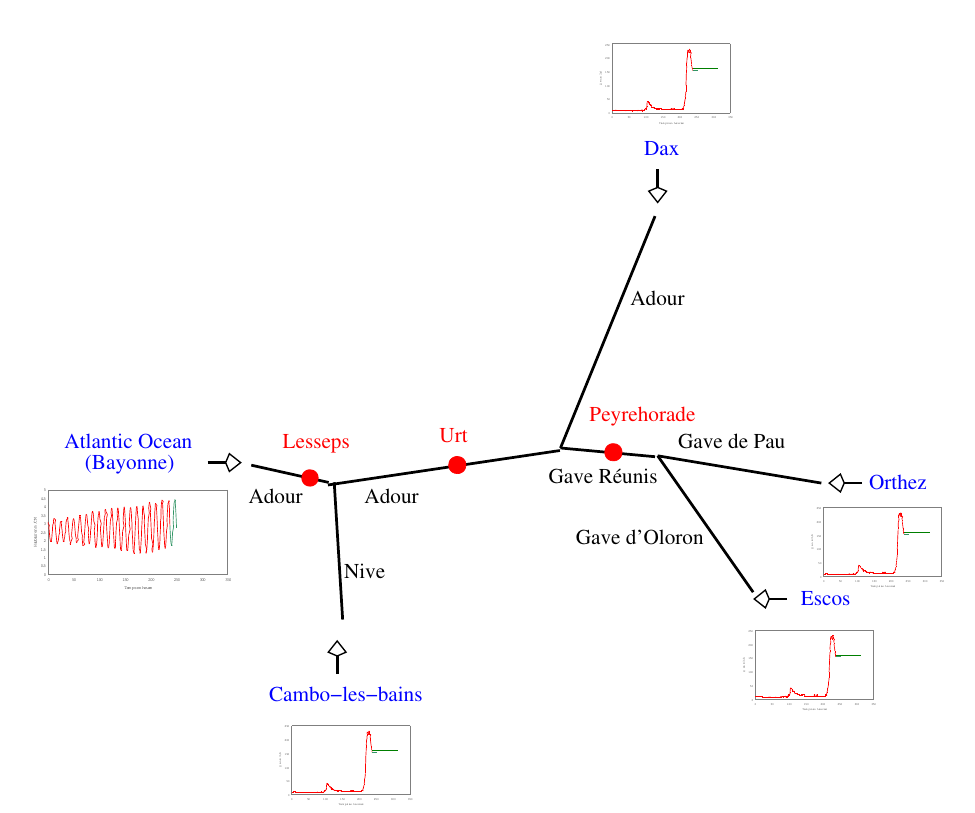
Fig. 6. The Adour catchment with the measurement stations in red and the upstream stations in blue.